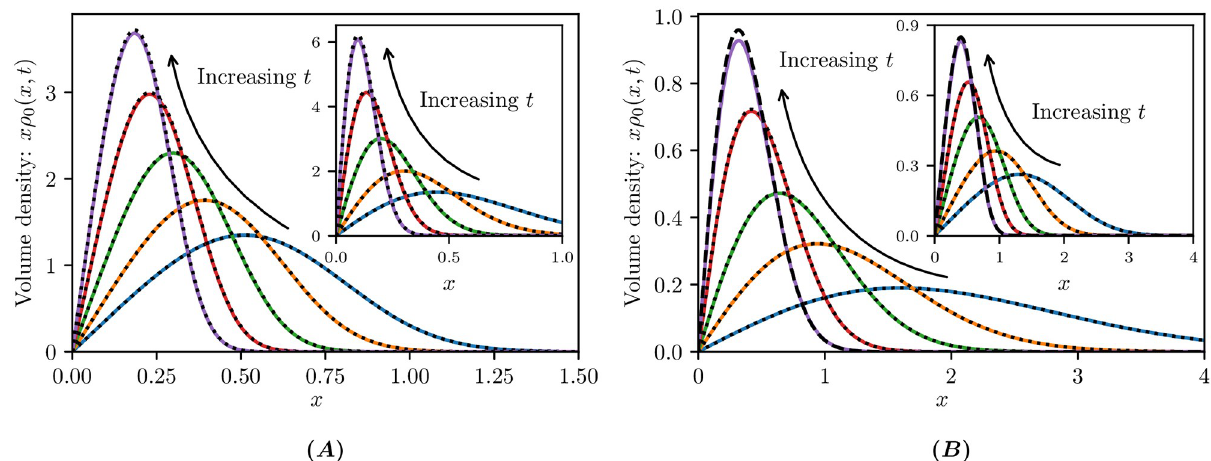
Fig 7. Growth–fragmentation processes. Analytical (black dotted curves) and numerical (coloured curves) solutions of growth–fragmentation equations at various times t . (A) Eq (25) with solution (26) at times t − t 0 2 {0, 0.6, 2, 5, 10} where t 0 = 0.5 and k = 3; (A inset) k = 2; (B) Eq (27) with solution (28) at times t − t 0 2 {0.04, 0.12, 0.4, 2} where t 0 = 0.02 and k = 2; (B inset) t − t 0 2 {0.017, 0.07, 0.2, 2} where t 0 = 0.01 and k = 3. The black dashed curves in (B) show the limiting profile as t ! 1 given by (29). Other parameters used are a = 5, Δ x = 0.005. Initial conditions are given by the analytical solution at time t = t 0